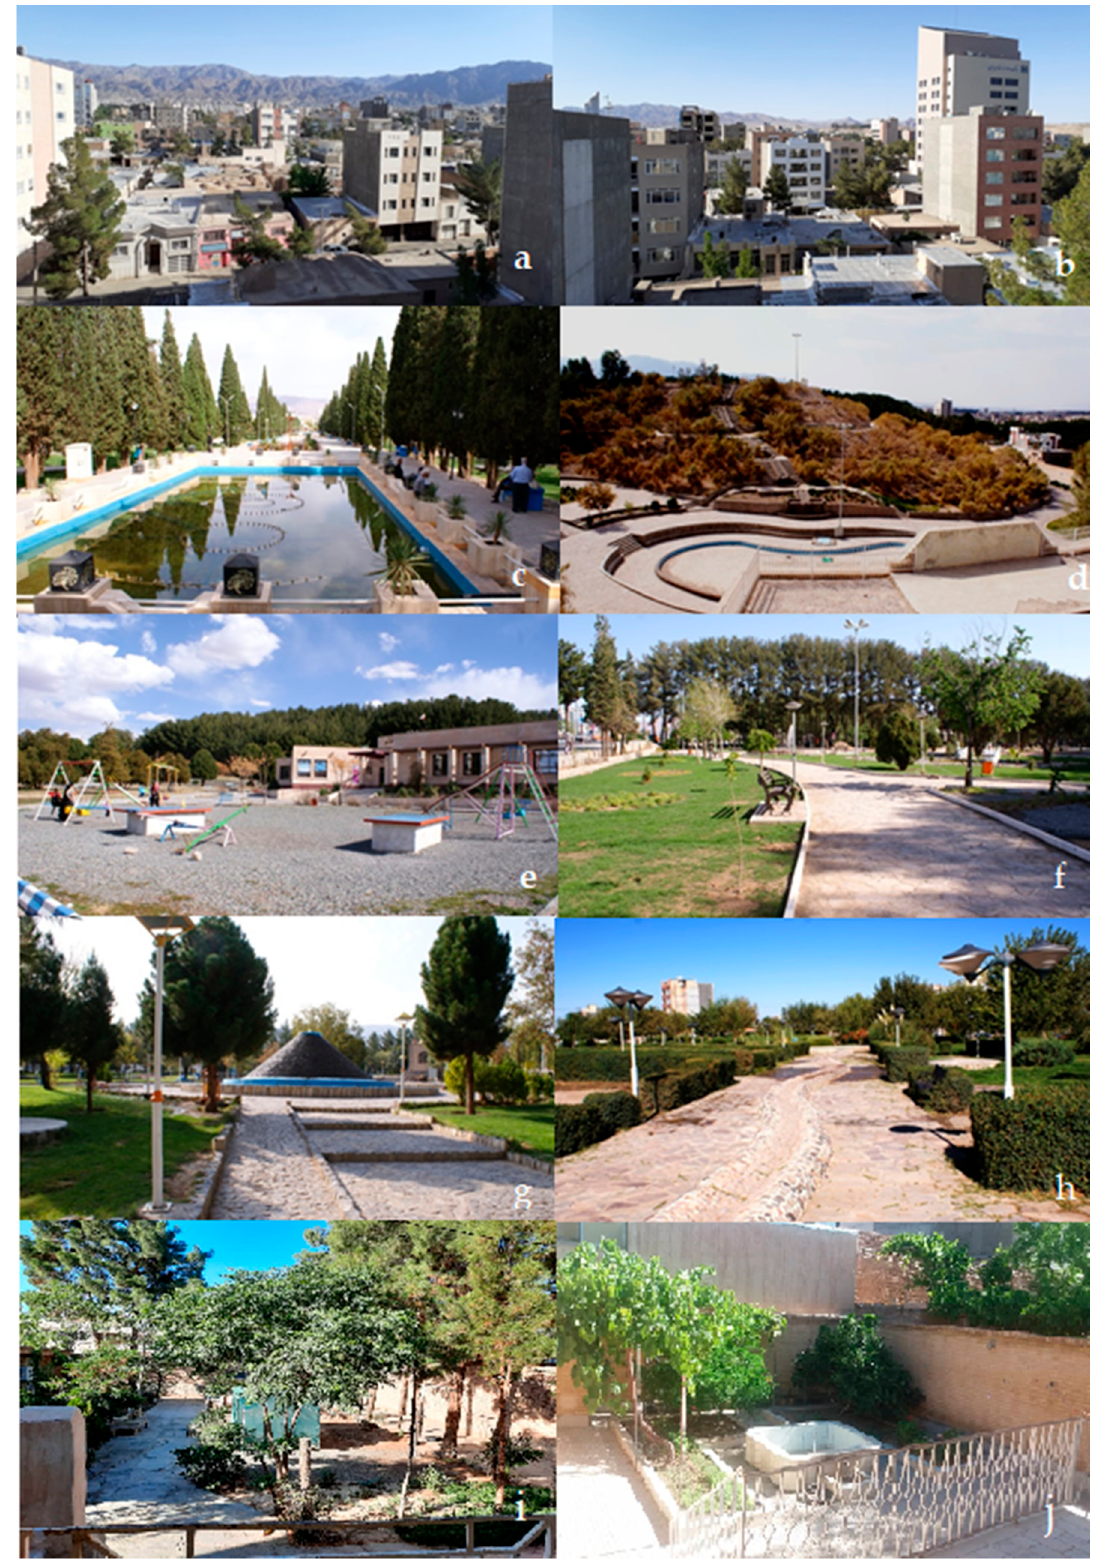
Figure 2. Photos of cityscape ( a , b ), city parks ( c , d ), district parks ( e , f ), neighborhood parks ( g , h ) and private large ( i ) and small ( j ) courtyards in Birjand.